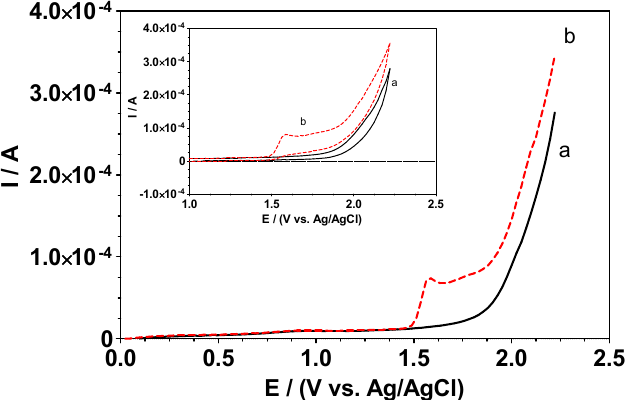
Figure 4. Linear polarization curves of (a) non-polluted and (b) polluted river water matrices with BDD anode at 50 mV s −1 as scan rate.